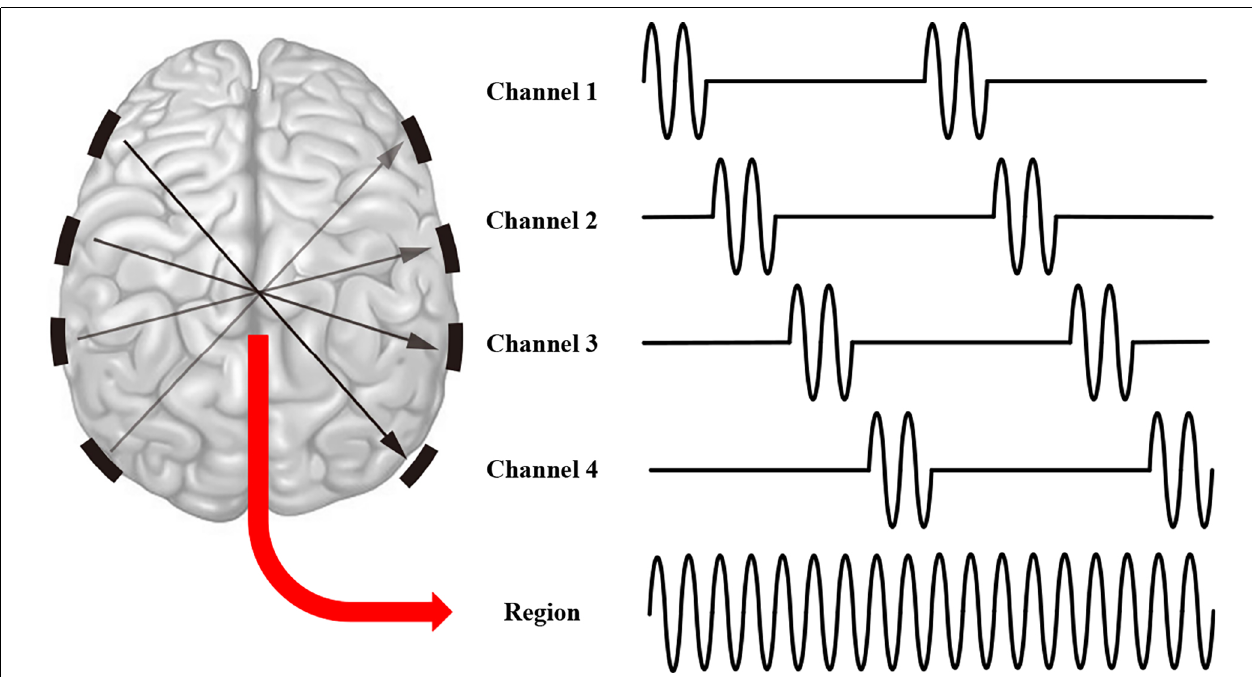
FIGURE 6 | Schematic diagram of intersectional short pulse (ISP)